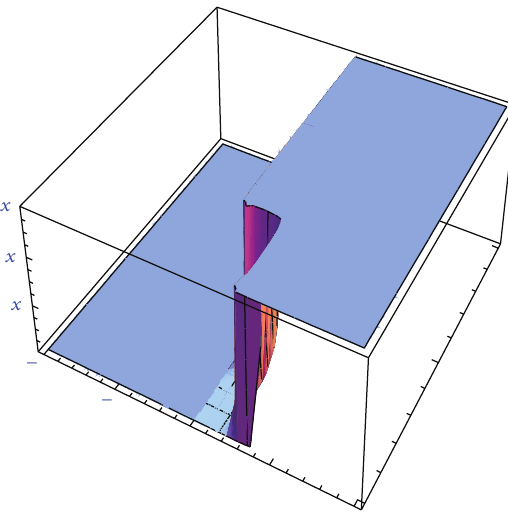
Figure 1: Special solution for 𝑚 = 4